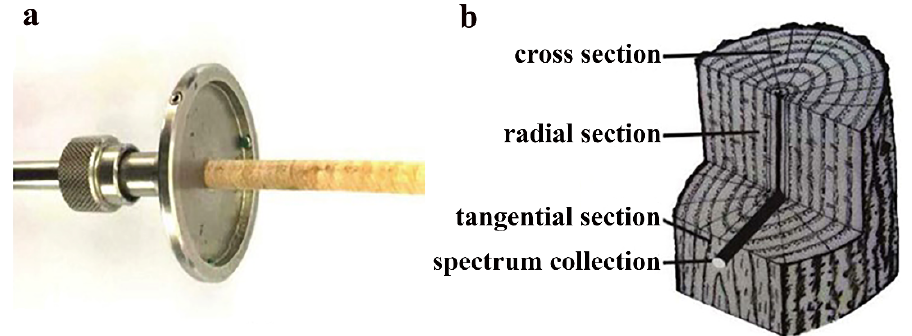
Figure 1. Schematic diagram of the spectral collection of the increment core sample.